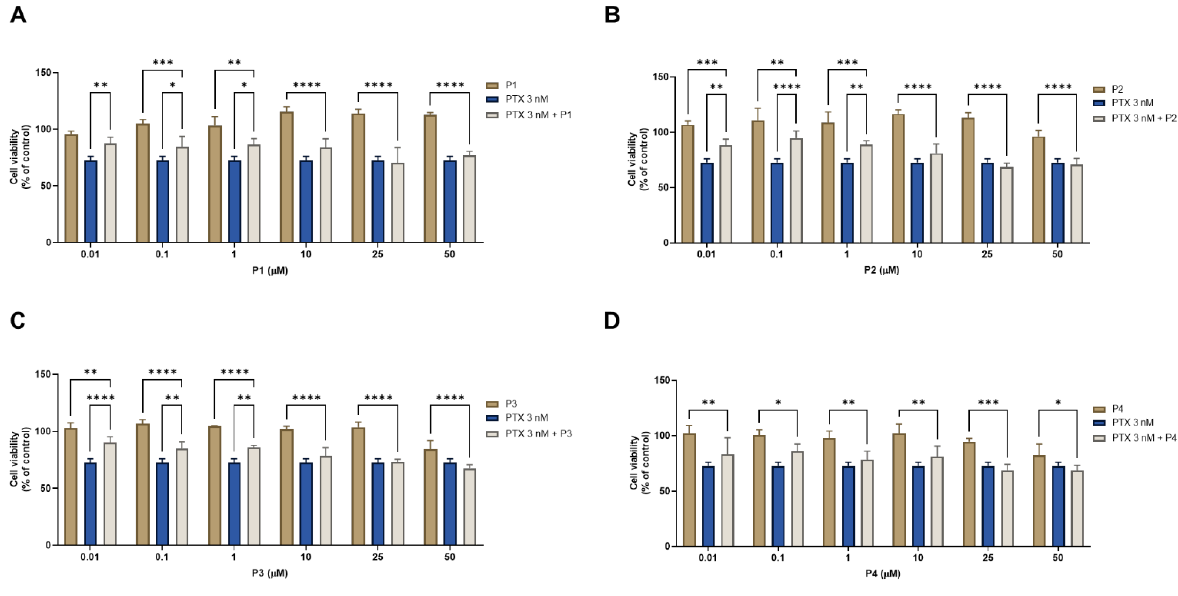
Figure 16. Cytotoxic results of MCF-7 after exposure to combinations of 3 nM of paclitaxel with increasing concentrations of the peptides ( A ) P1, ( B ) P2, ( C ) P3, and ( D ) P4 (0.01 – 50 μM) for 48 h. Control cells were treated with 0.01% DMSO (vehicle). Cell viability was obtained using the MTT assay, and the results are given as the mean ± SEM ( n = 3). * Statistically significant vs. drug alone at p < 0.05, ** statistically significant vs. drug alone at p < 0.01, *** statistically significant vs. drug alone at p < 0.001, **** statistically significant vs. drug alone at p < 0.0001.